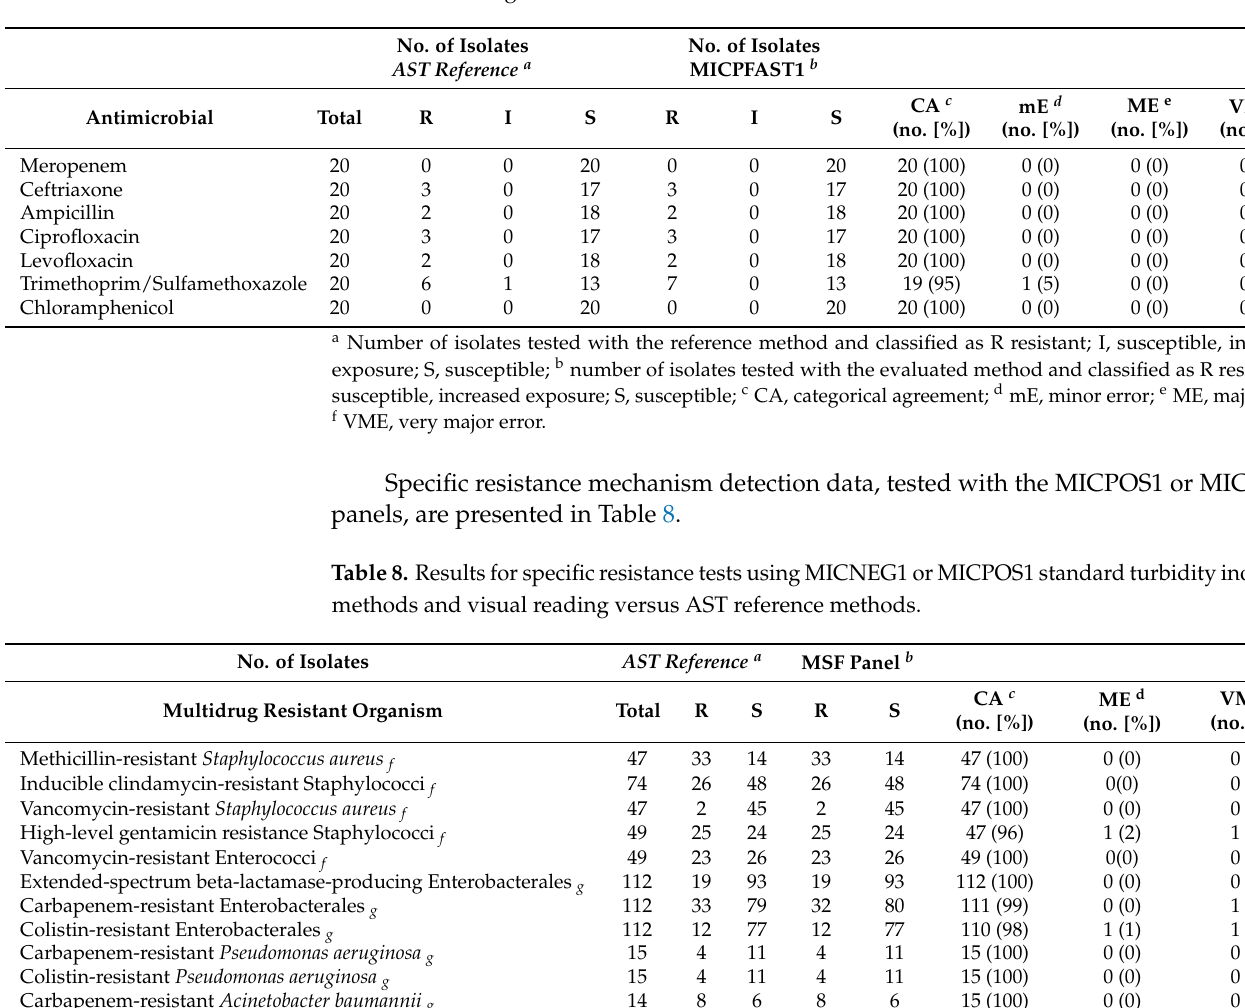
Table 7. Results for the H. influenzae test with the MICFAST1 standard turbidity inoculum method and visual reading versus AST reference methods.